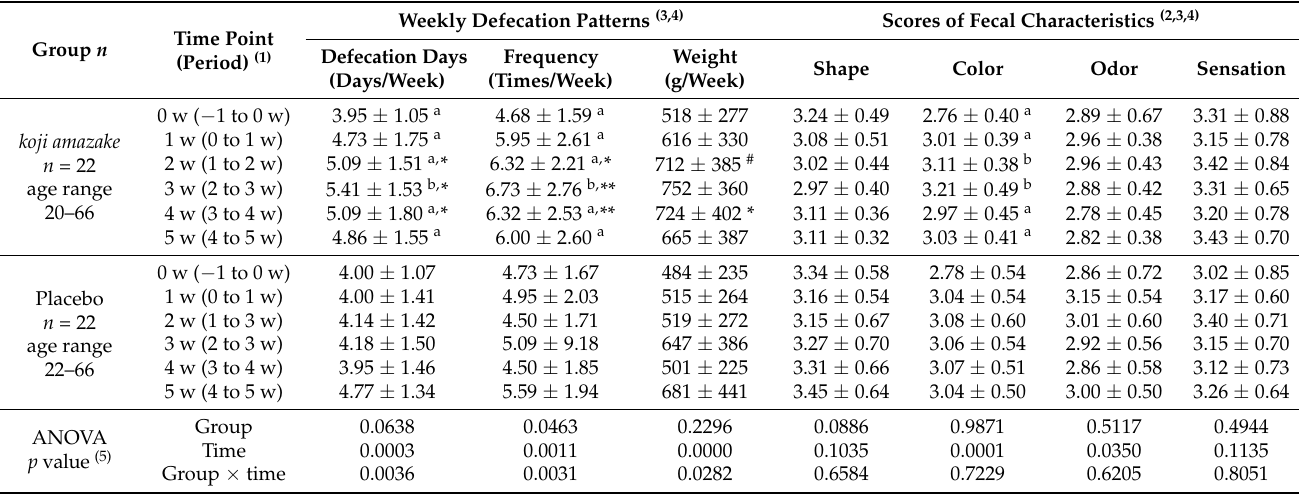
Table 2. Weekly values and the statistical analysis of defecation patterns (frequency and weight) and fecal characteristics of a koji amazake group and placebo groups during a 6-week study period.